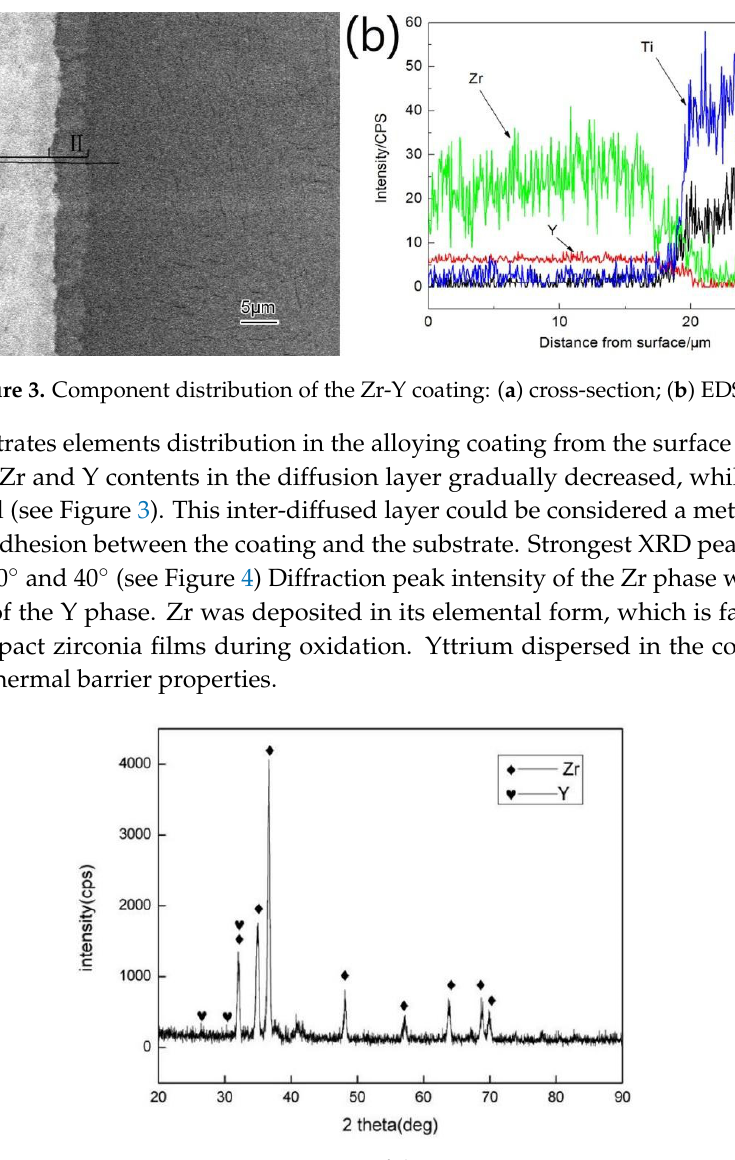
Figure 2. SEM morphologies and surface chemical composition of the alloying coatings: ( a ) Zr; ( b ) Zr-Y.